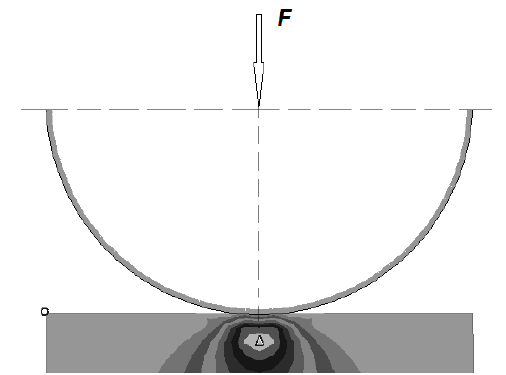
Figure 1. Scheme of realizing the contact of a rigid tool with a specified curvature on a deformable object.